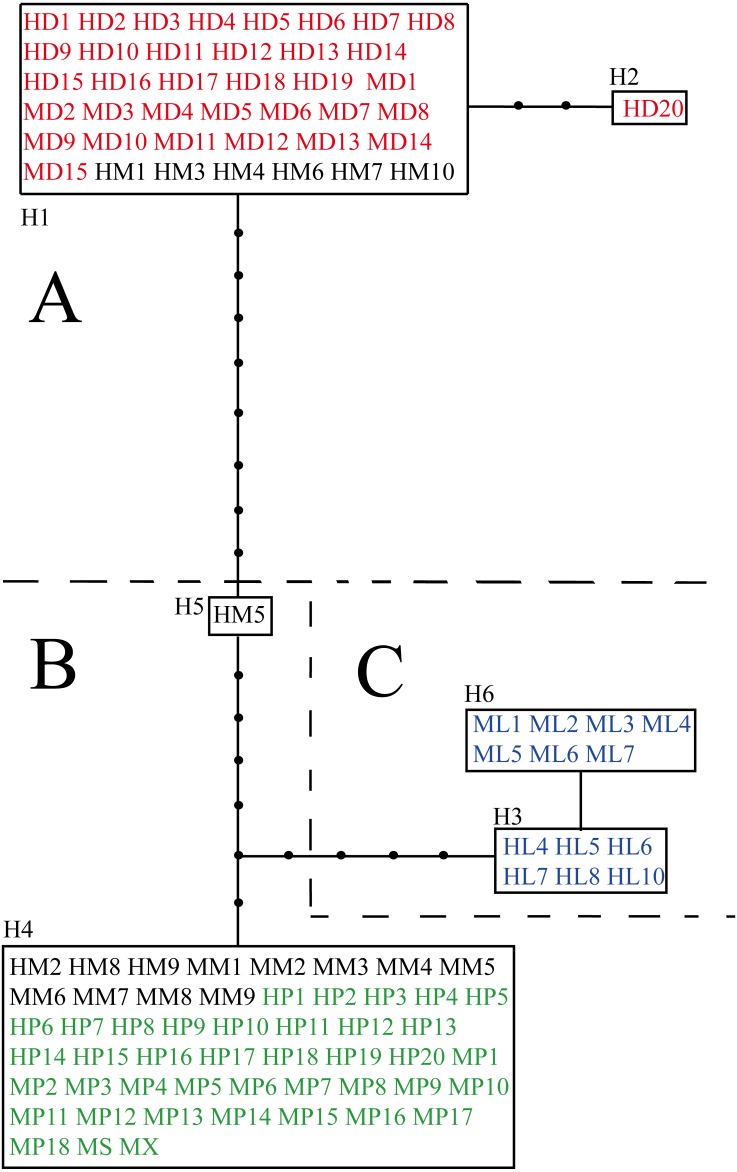
Haplotype network inferred from cpDNA data.Each rectangle represents one haplotype, and the black circles represent haplotypes not detected. Red and green symbols represent sequences of parental L. duciformis (A) and L. paradoxa (B), respectively. Black and blue symbols represent sequences of putative hybrids (A and B) and sympatric L. lamarum (C), respectively. (A) Population locality: M, Mt. Maoniu; H, Heihai Lake; (B) taxa: D, L. duciformis; P, L. paradoxa; M, L. ×maoniushanensis; L, L. lamarum. Numbers following taxon initials are sample numbers (if any).